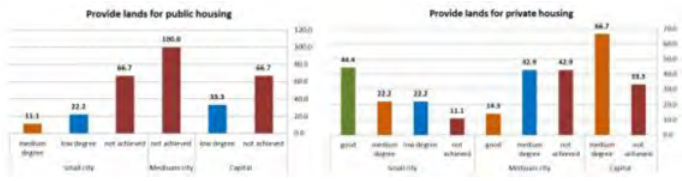
Figure 4. Provision of landsfor